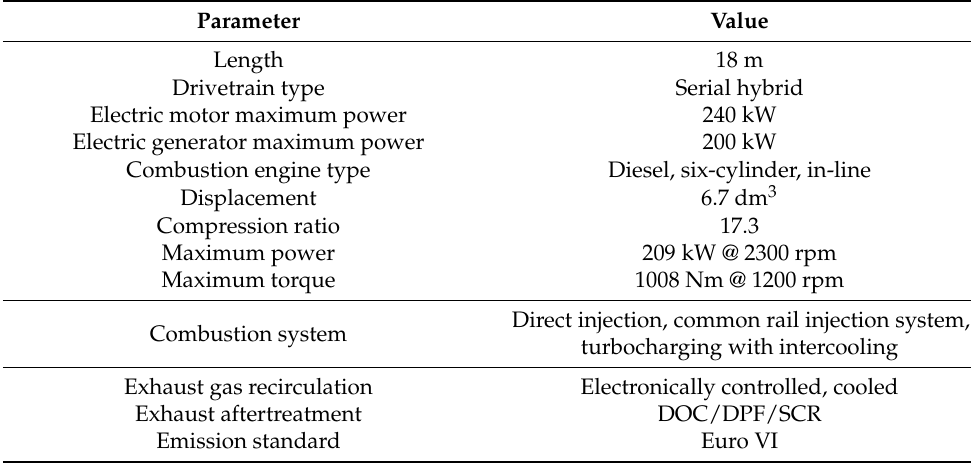
Table 7. Specifications of the hybrid city bus used in the